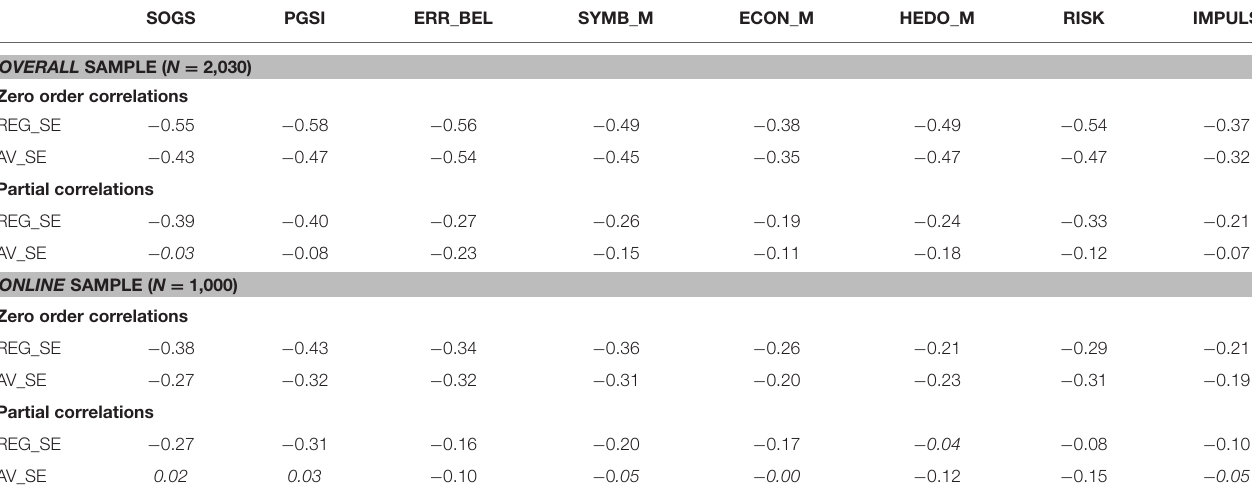
TABLE 5 | Zero-order and partial correlations of MGSES dimensions with other scales related to gambling. SOGS